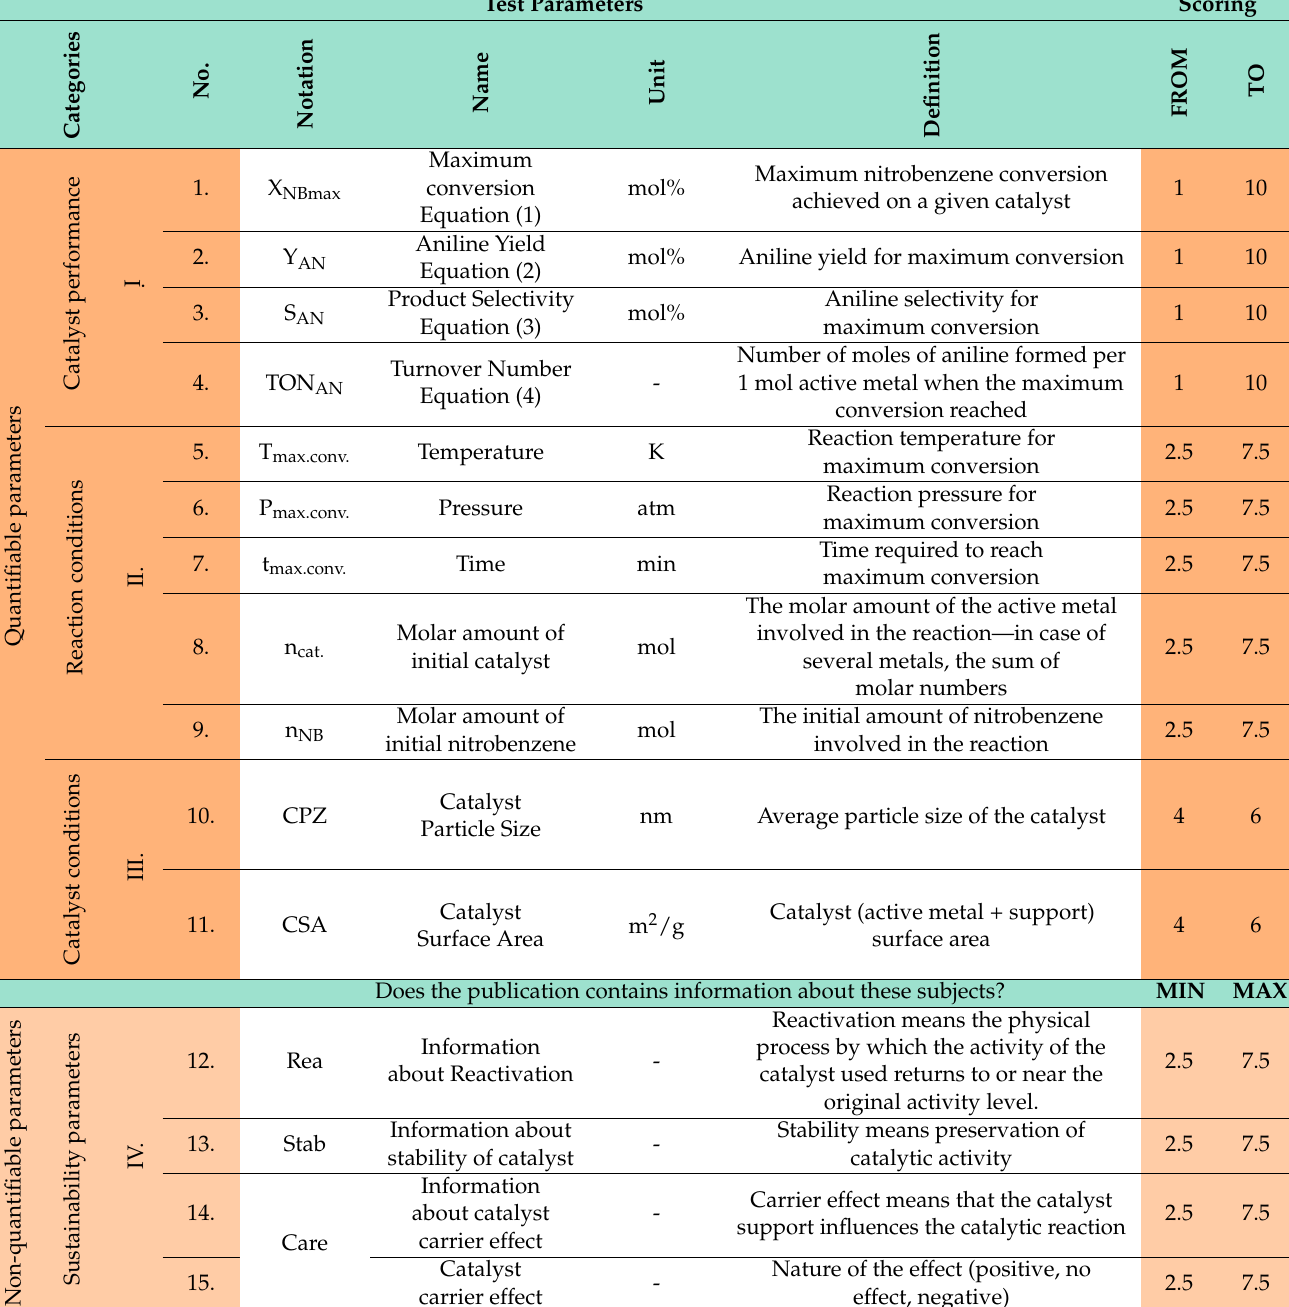
Table 2. Descriptor system of MIRA21 model.